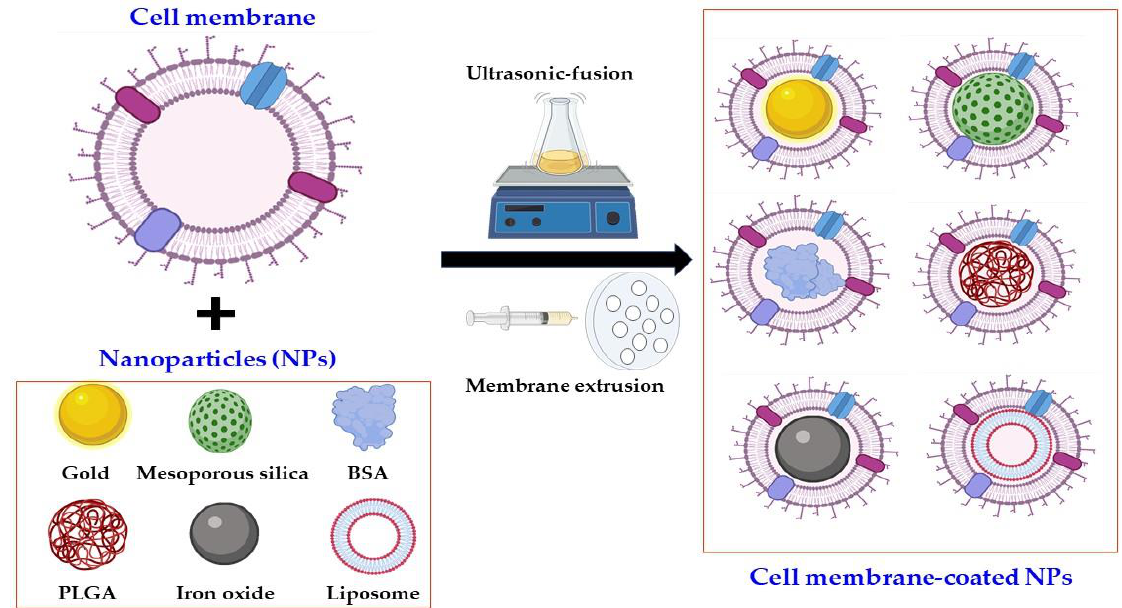
Figure 2. Schematic representation of different cell membrane coatings of NPs with ultrasonic fusion of the membrane extrusion process.